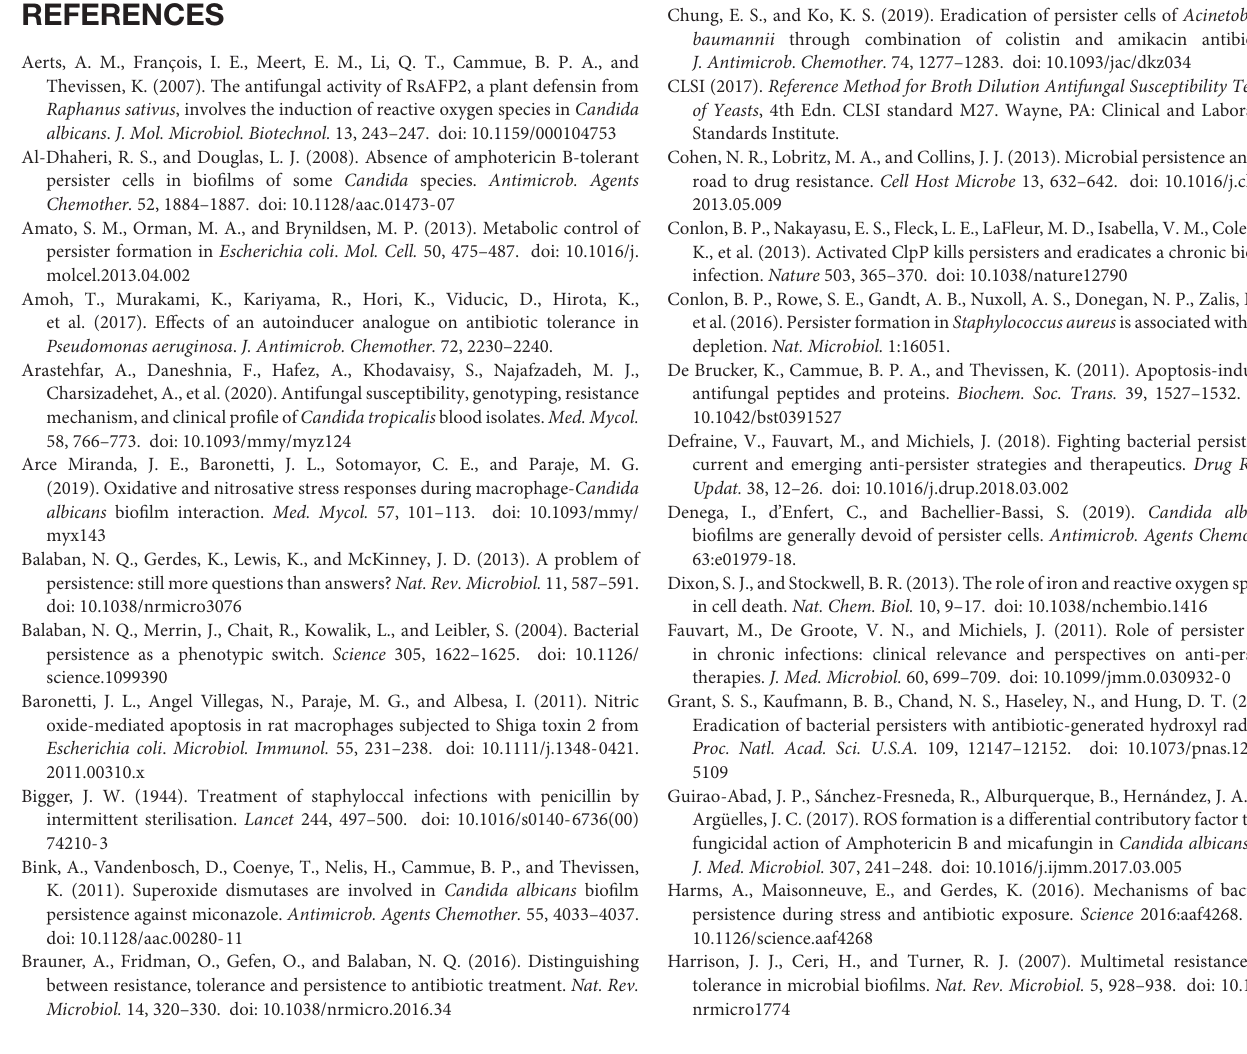
Supplementary Figure 1 | Percentage of surviving sessile cells (% survival) determined by colony-forming units per mL (CFU mL − 1 ) count and correlating this with results obtained by crystal violet (CV) staining as biofilm biomass unit (BBU). Supplementary Figure 2 | Cellular stress metabolites and oxidative stress responses (OSR) of untreated and treated Amphotericin B (AmB) at sessile minimum inhibitory concentration 80 (SMIC80) in biofilms 1 (B1) and biofilms 2 (B2). All experiments were performed in triplicate, for three independent experiments, and the numerical data are presented as means ± standard deviation. ∗ denotes statistical significance at p < 0.01 for differences when compared with untreated biofilms. # p < 0.01 differences considered significant for comparisons between B1 and B2. The numerical data correspond to the relative values (treated/untreated ratio) shown in Figure 4B